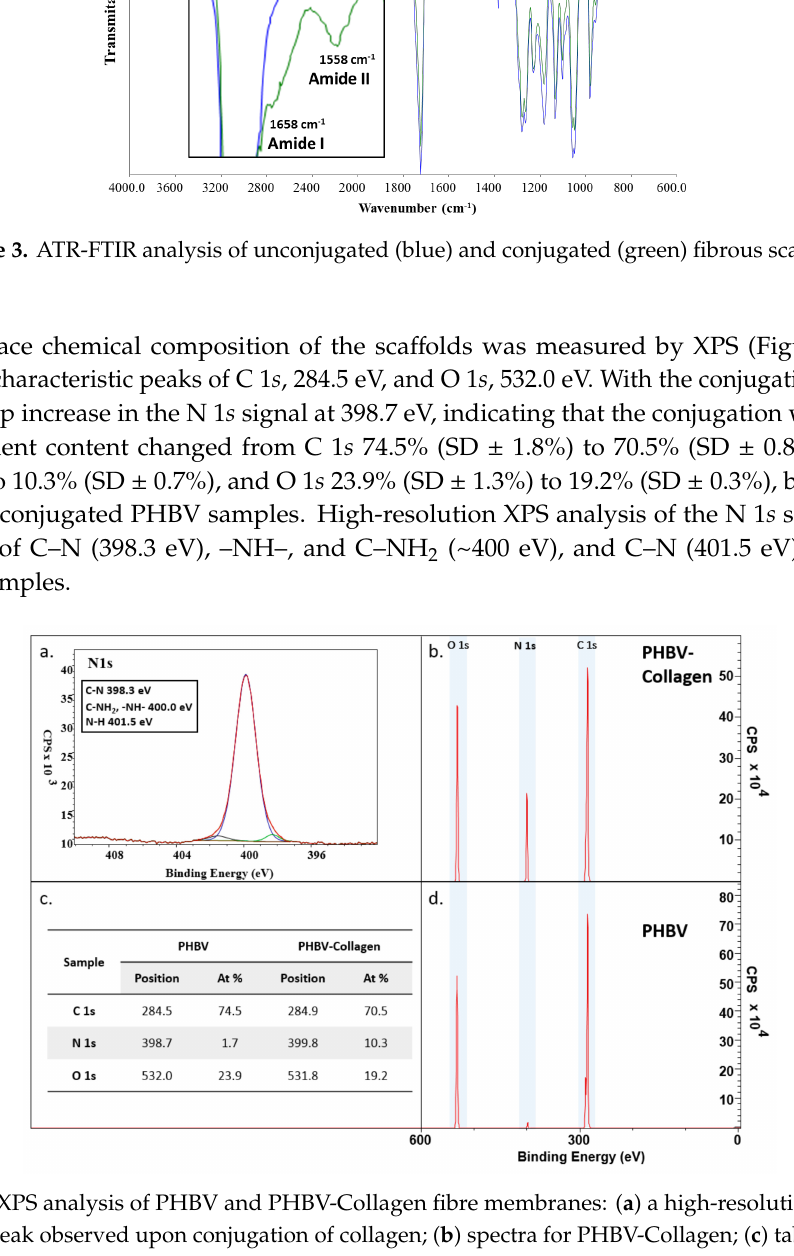
Figure 3. ATR-FTIR analysis of unconjugated (blue) and conjugated (green) fibrous scaffolds